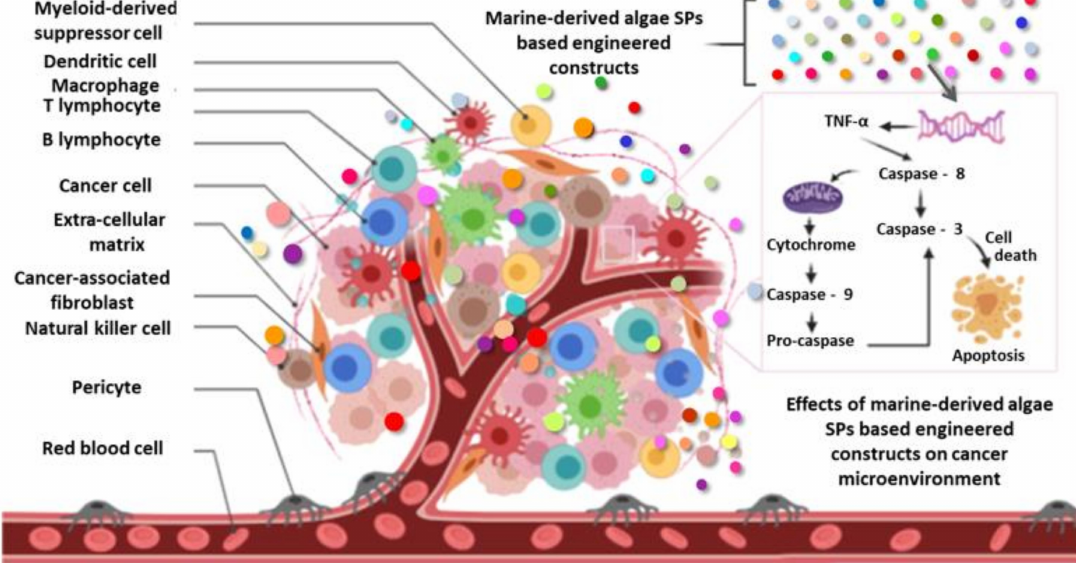
Figure 13. Potentials of marine-derived algae polysaccharide (SP)-based engineered cues to induce cell death of tumor cells